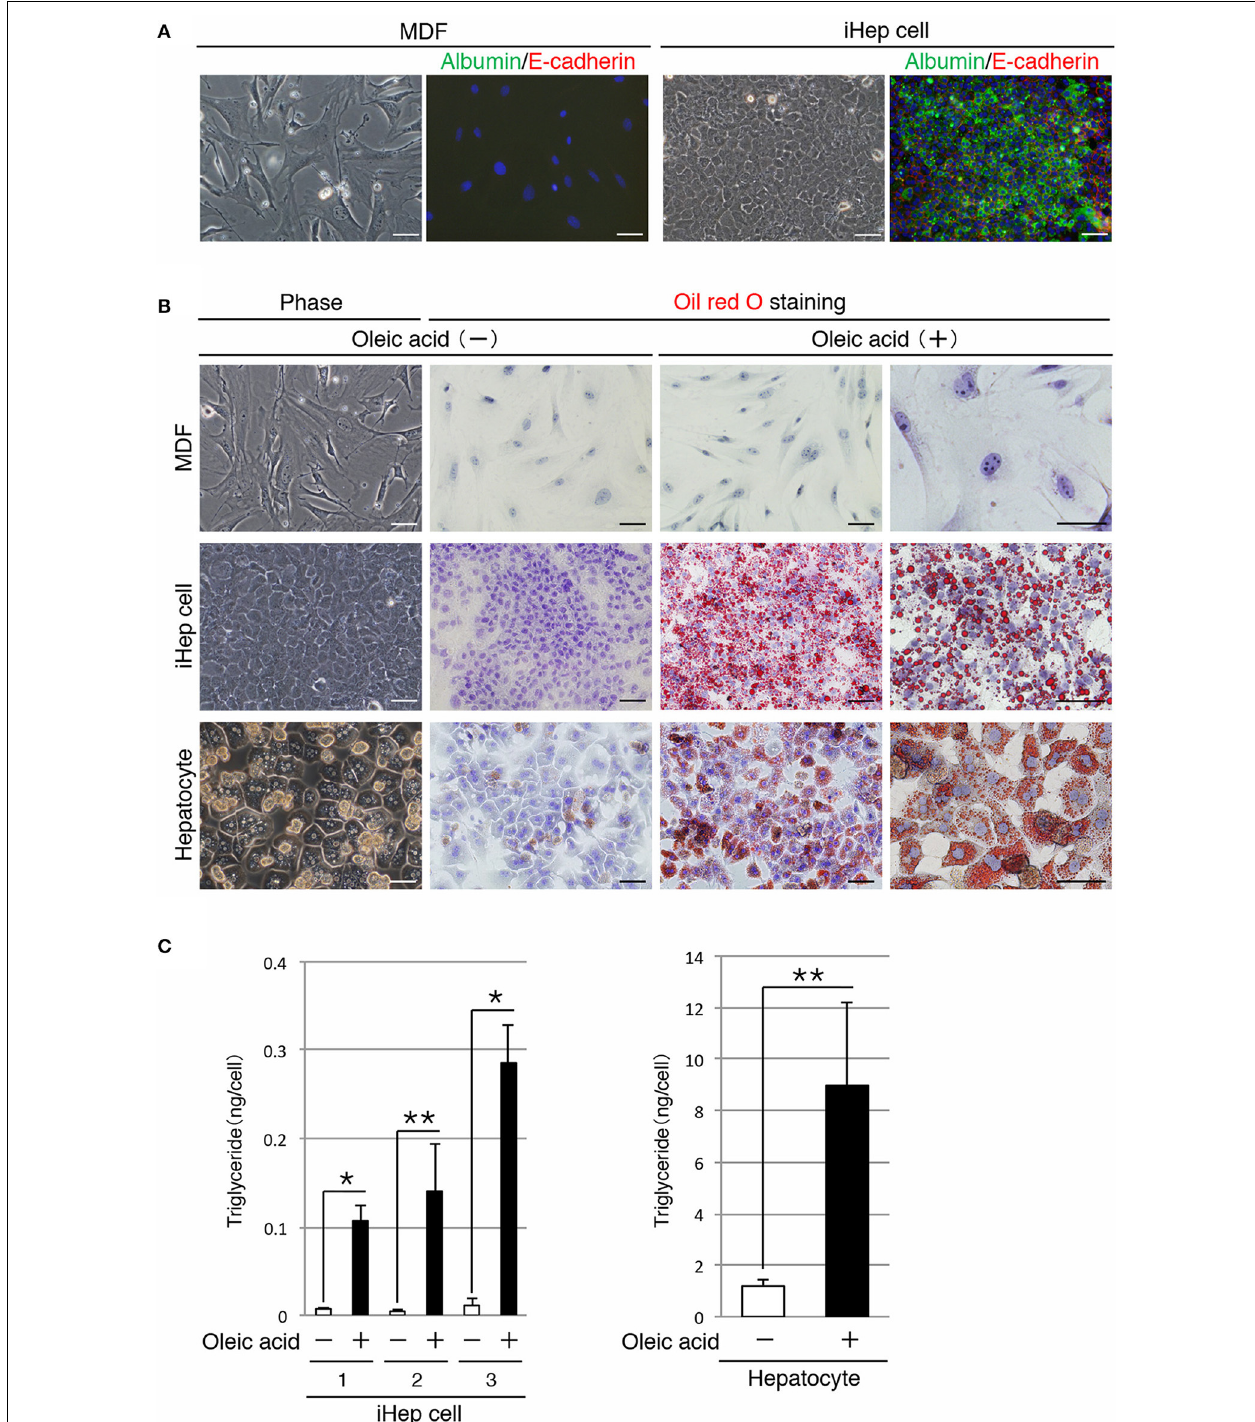
FIGURE 1 | iHep cells can synthesize lipids from a cis-unsaturated fatty acid. (A) Morphologies of MDFs and MDF-derived iHep cells. Co-immunofluorescence staining of albumin and E-cadherin was conducted for MDFs and iHep cells. DNA was stained with DAPI. (B) iHep cells can synthesize and store abundant lipids in cultures containing oleic acid, a cis-unsaturated fatty acid. Phase-contrast images of MDFs, iHep cells, and primary hepatocytes in cultures without oleic acid are shown. Oil red O